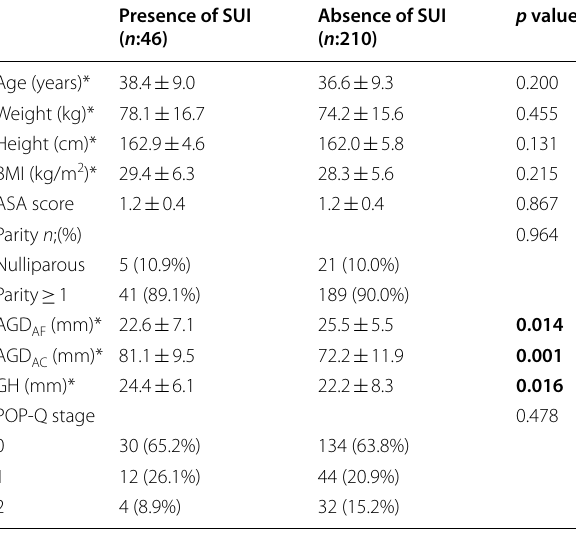
Table 2 Comparison of patient data by stress urinary